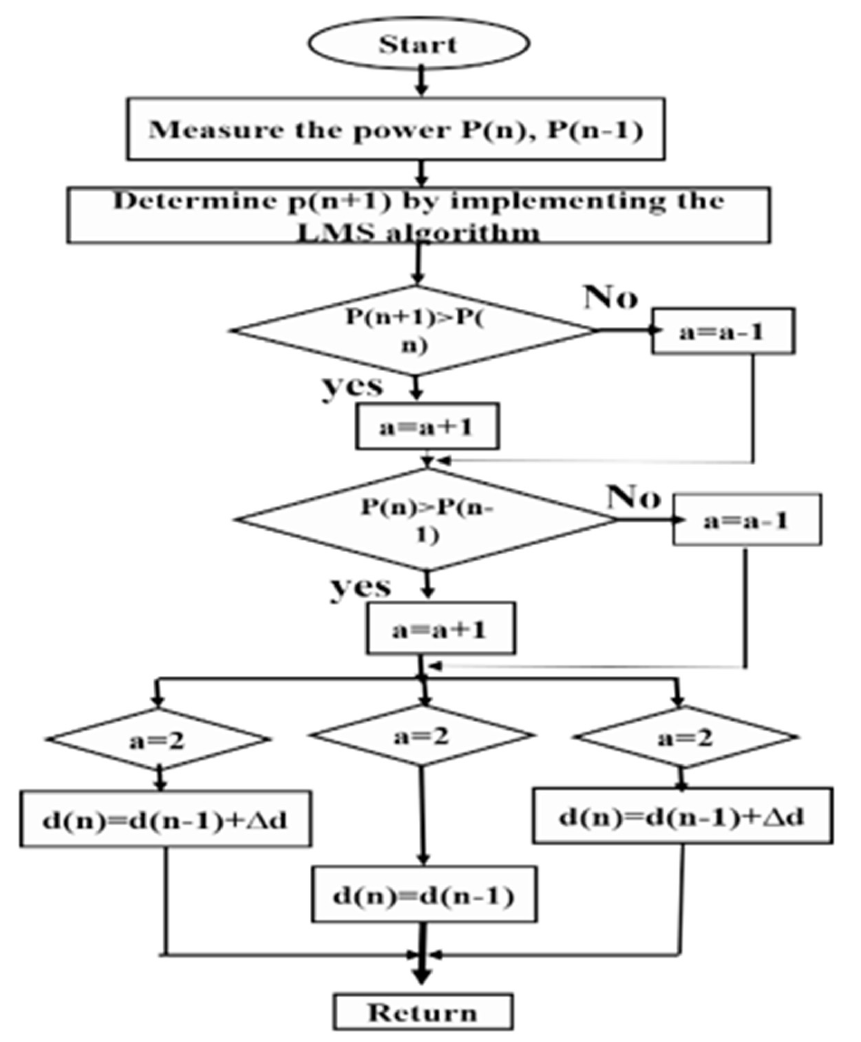
Figure 5. Flow chart of the adaptive LMS MPPT